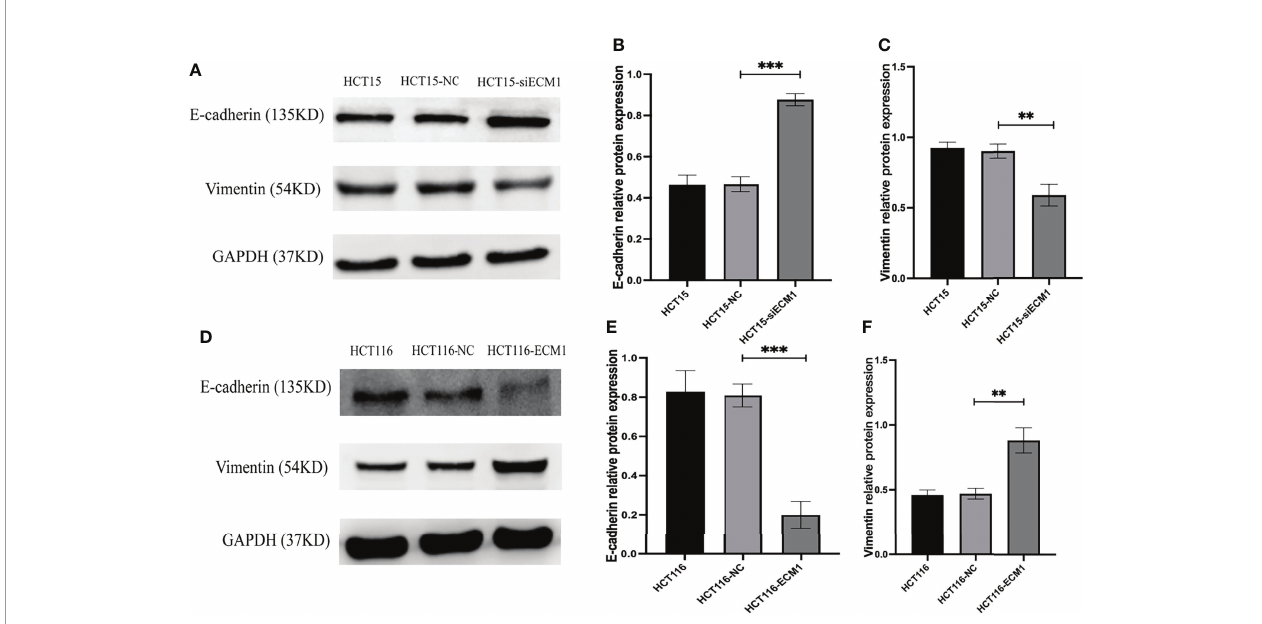
FIGURE 5 | ECM1 regulates CRC cell EMT induction. EMT-related protein expression was analyzed following the knockdown or upregulation of ECM1. (A – C) Vimentin and E-cadherin protein levels were assessed in HCT15, HCT15-NC, and HCT15-siECM1 cells. (D – F) Vimentin and E-cadherin protein levels were investigated in HCT116, HCT116-NC, and HCT116-ECM1 cells. Data are means± SD (**P < 0.01, ***P <